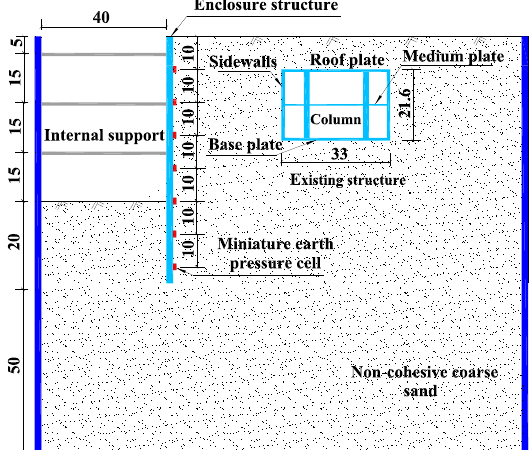
Figure 10. Model test section.